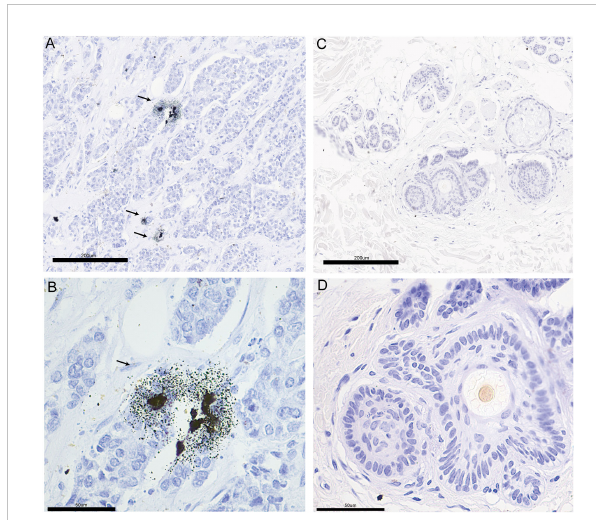
FIGURE 11 The copper stain of BRCA patients ’ paraf fi n section using Timm ’ s method. Copper staining of the pathological section of breast cancer ( A : 20x, B : 40x) and paired paracancerous ( C : 20x, D : 40x) sample. The copper-positive areas contain small black granules. Coarse granules indicated intense copper deposition. The arrows indicate the distribution of copper in pathological